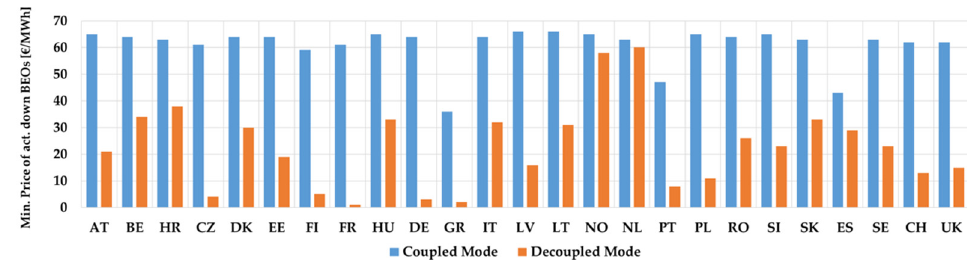
Figure 14. Minimum price of activated downward BEOs in each participating control area.